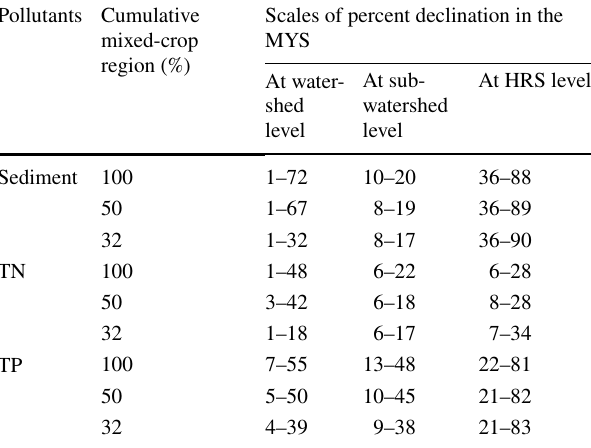
Table 5 TN, TP, and Sediment percent reduction limit for the BMPs Pollutants Cumulative mixed-crop region